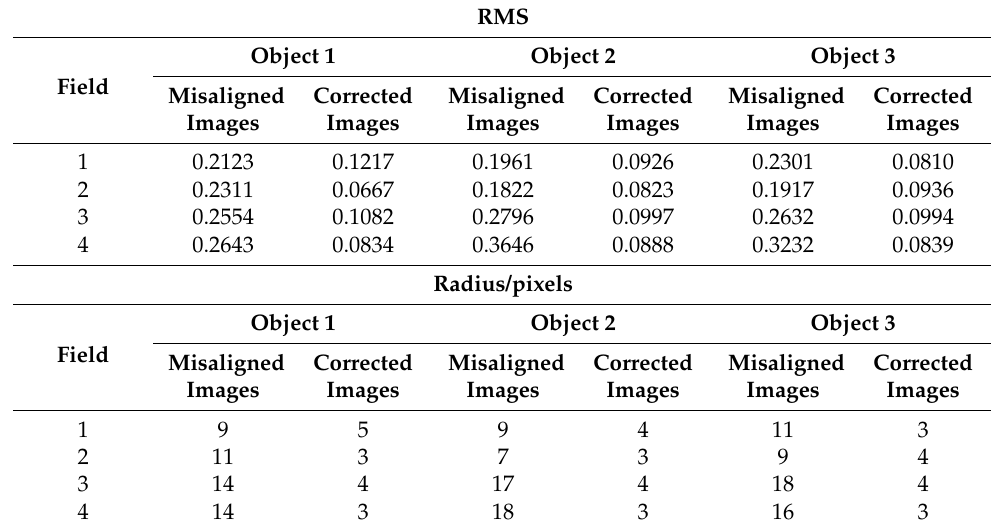
Table 3. Root mean square radius (RMS) and radius of misaligned and corrected